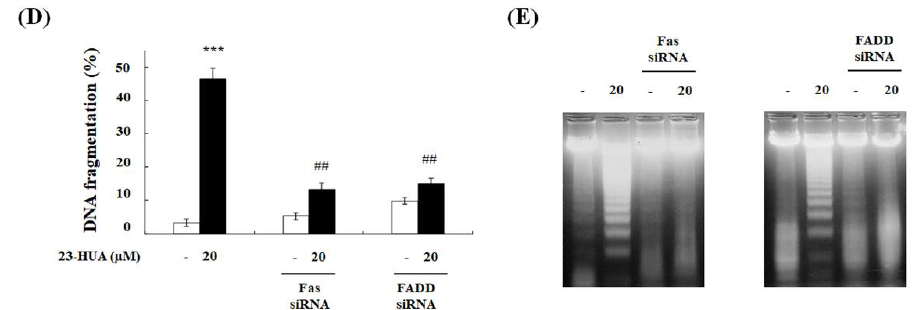
Figure 4. Effect of 23-HUA on Fas-related proteins expression in HL-60 cells. ( A ) Proteins expression levels were measured by western blot analysis in 20 µM 23-HUA-treated HL-60 cells (0, 0.25, 0.5, 1, 2 and 4 h). β -Actin was used as an internal control. ( B ) Cell lysates immunoprecipitation with anti-FADD antibody followed by western blot analysis (IP: immunoprecipitation). ( C ) HL-60 cells transfected with Fas or FAD siRNA were treated with 20 µM 23-HUA for 6 h. Proteins expression levels were measured by western blot analysis. β -Actin was used as an internal control. ( D ) HL-60 cells transfected with Fas or FADD siRNA were treated with 20 µM 23-HUA for 6 h. 23-HUA-induced DNA fragmentation was measured by DAPI assay. ( E ) Apoptotic DNA fragmentation was detected by 2% agarose gel electrophoresis and visualized by ethidium bromide stain. Values are the means ± SD of triplicate experiments. *** p < 0.001 vs. control group, ## p < 0.01 vs. 23-HUA-treated group.